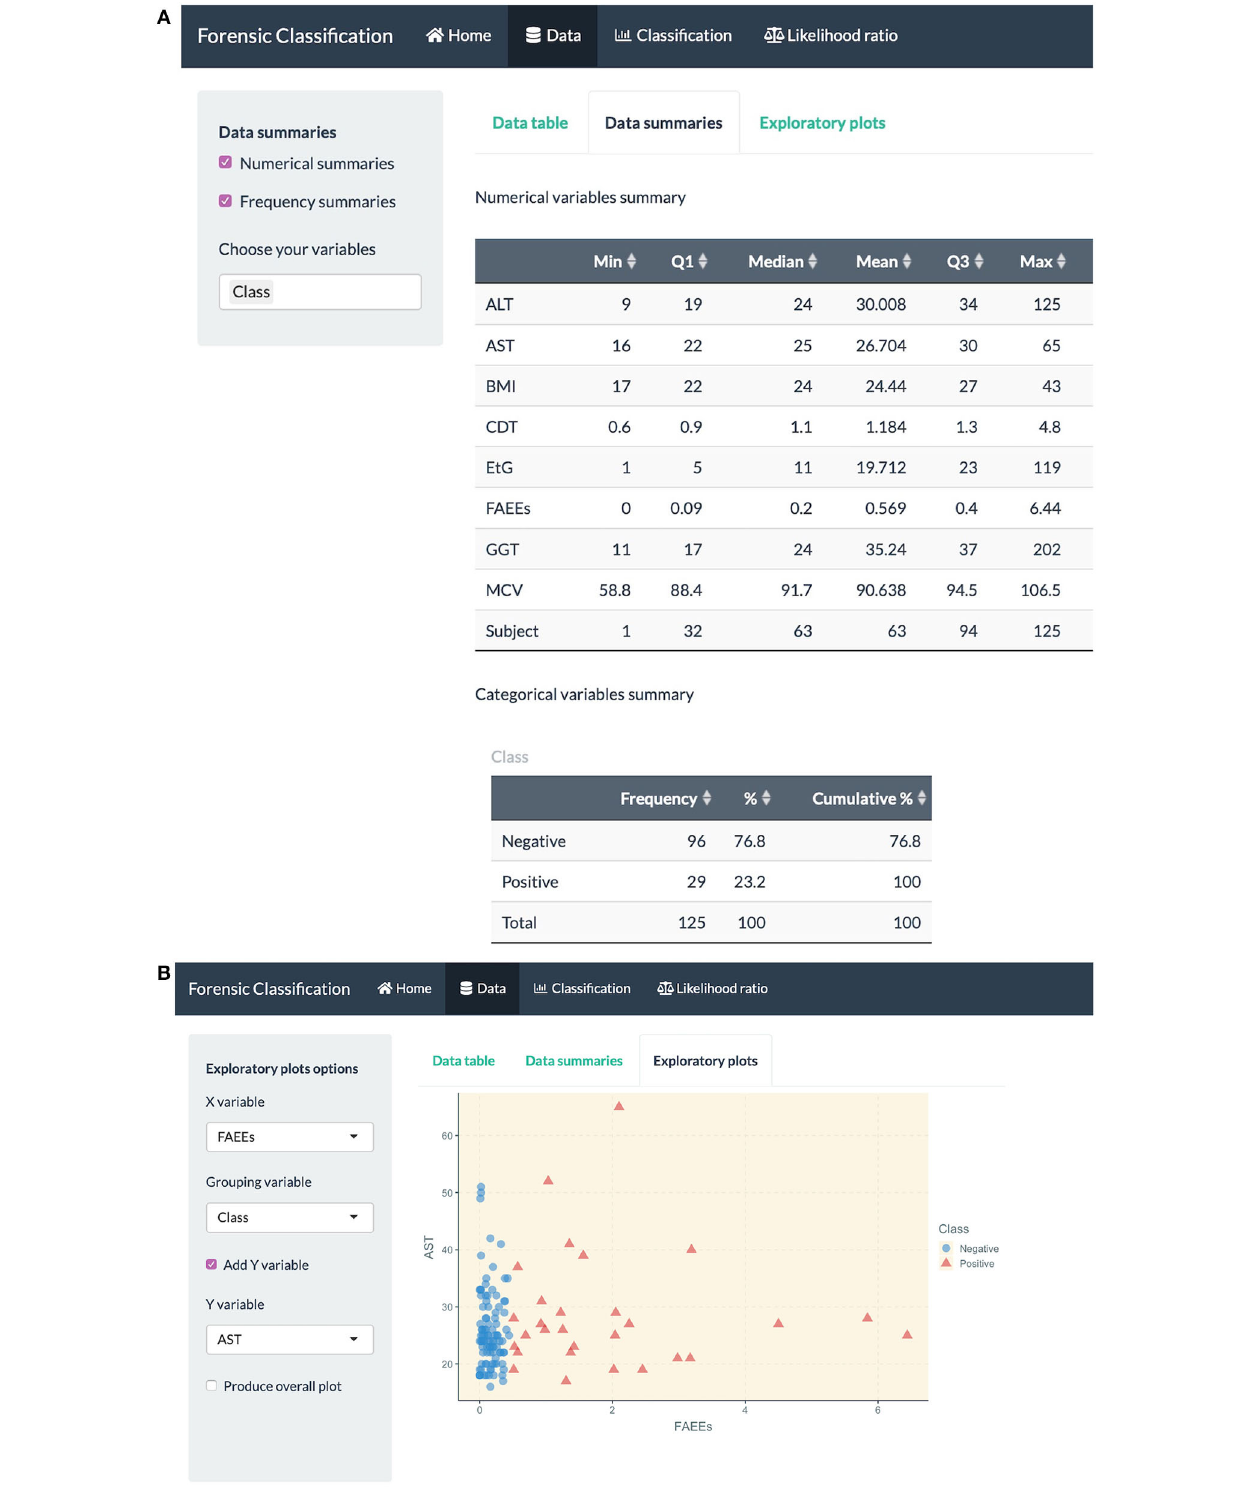
FIGURE 4 | R Shiny app: “Data” tab screenshots, showing (A) numerical summaries for variables in the alcohol biomarkers dataset (B) exploratory plots.